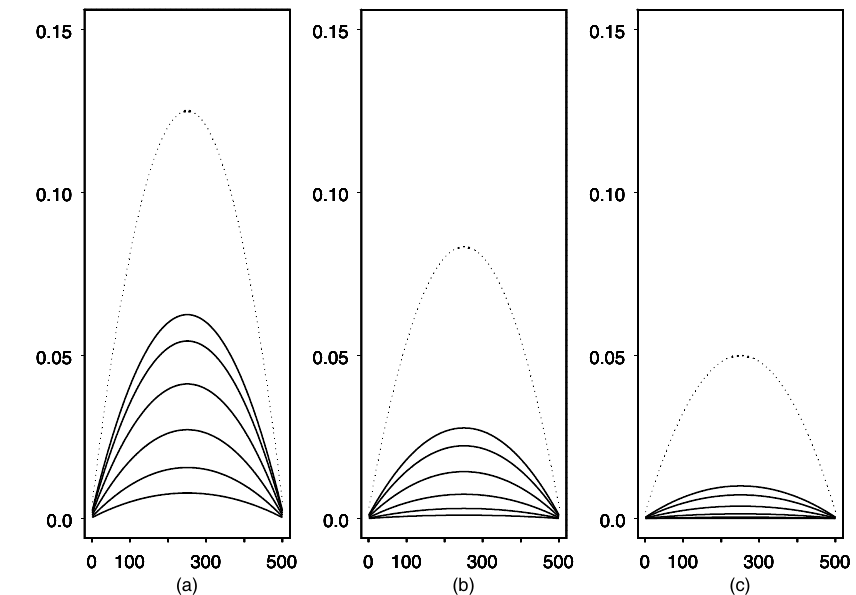
Figure 2 – The difference